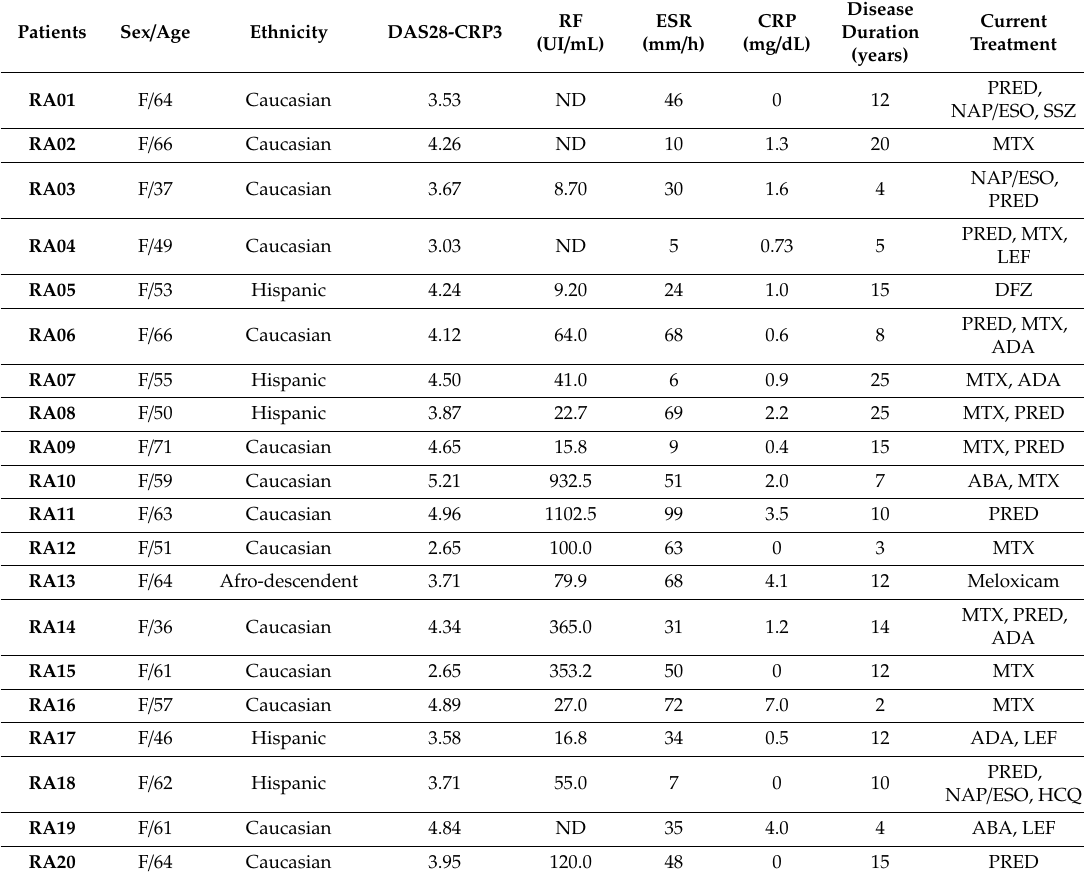
Table 1. Demographic and clinical characteristics from rheumatoid arthritis patients receiving disease modifying antirheumatic drugs